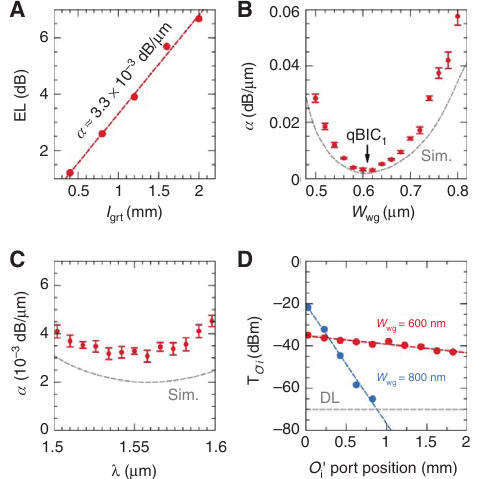
. SEM images for fabricated (B) Si grt